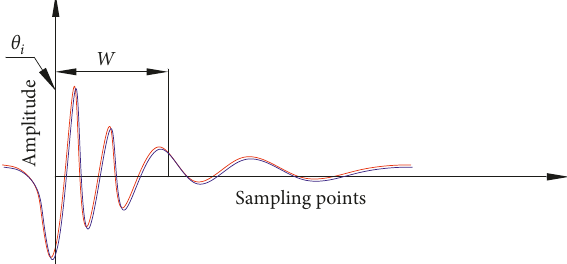
Figure 6: Situation where the fault component is